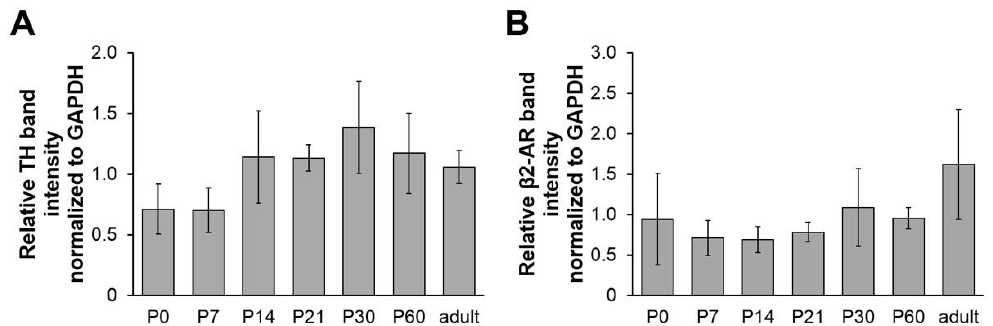
Figure 4. Total amounts of TH and β2AR in hindleg muscles do not vary significantly during postnatal development. Mouse tibialis anterior muscles from animals aged zero days (P0) to six months (adult) were sampled, lysed, and subjected to SDS-PAGE followed by Western blot analysis. In each lane, the same amount of protein was loaded. Western blot used antibodies against TH ( A ) or β2AR ( B ). Glyceraldehyde 3-phosphate dehydrogenase (GAPDH) was employed as a loading control. Bar graphs depict TH or β2AR band intensities relative to their corresponding GAPDH band (mean ± SEM; n = 4 mice for each time point).